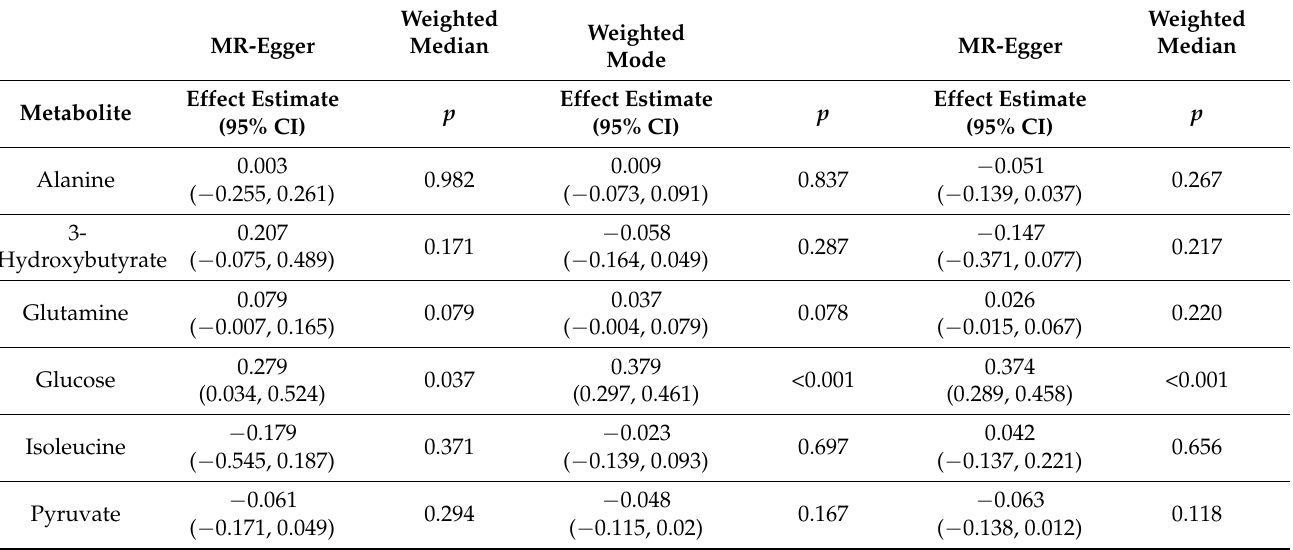
Table 2. UVMR estimates obtained from a range of estimation methods as a sensitivity test to explore the presence of horizontal